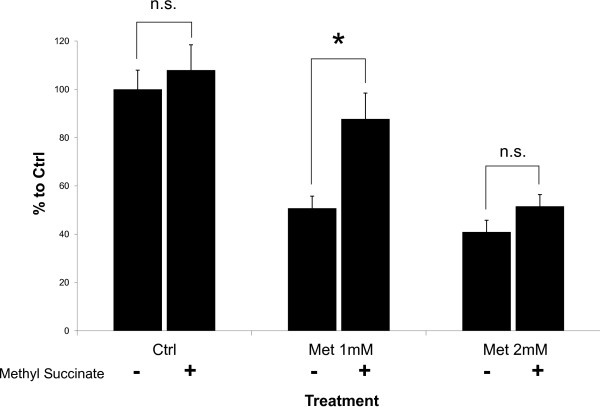
Methyl succinate partially reverses metformin's effects. When 12.5 mM methyl succinate is added to complete growth media, the 48 hour growth inhibition effects of metformin on PA-1 are reduced. Methyl succinate serves as an alternate energy source to glucose that bypasses complex I in the electron transport chain. Metformin at higher doses can overcome the reversal of growth inhibition provided by methyl succinate. * p < 0.01.